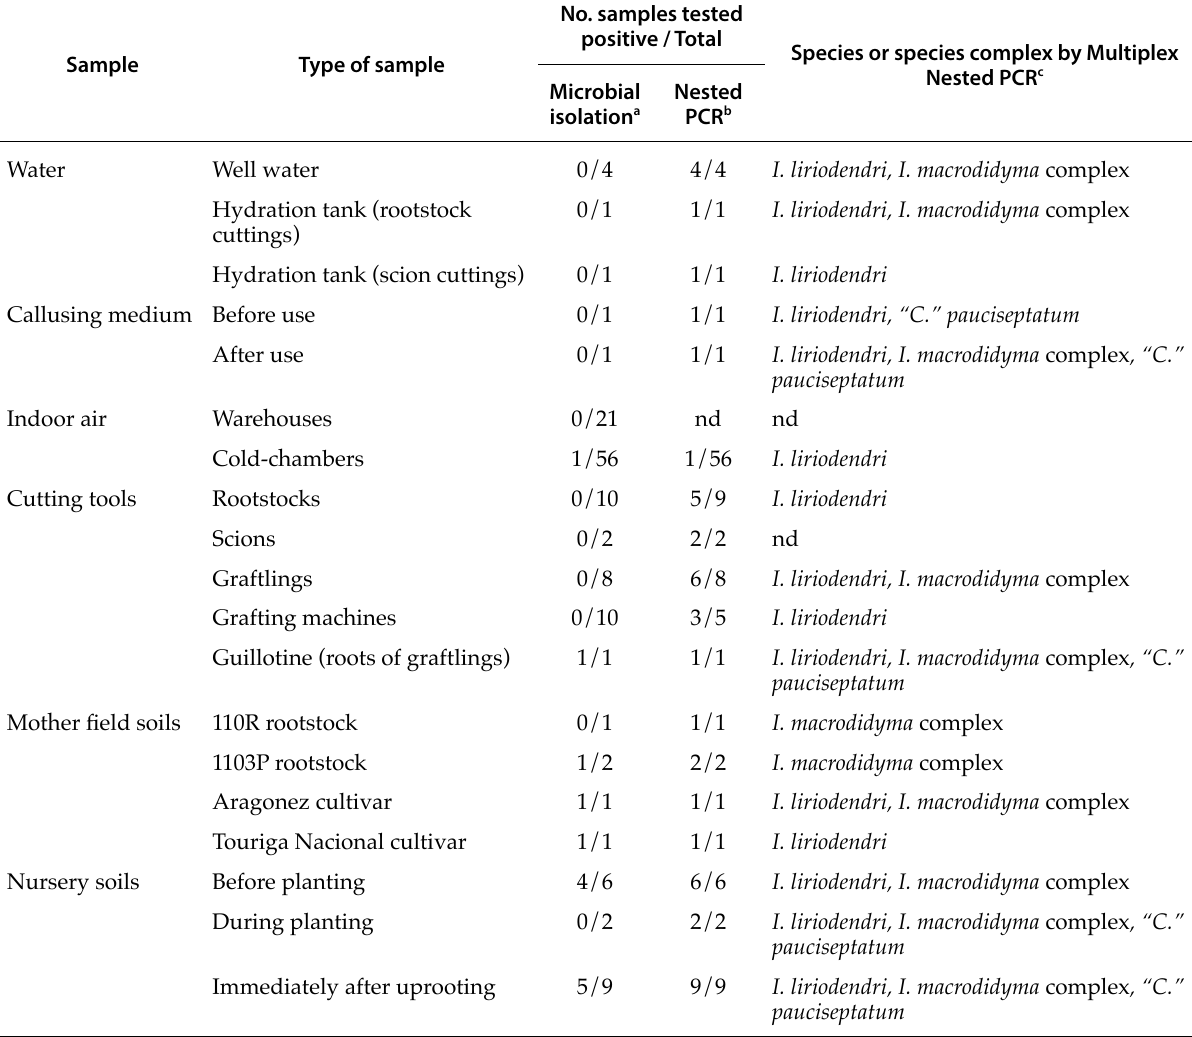
Table 2. Detection of Ilyonectria liriodendri , I. macrodidyma complex and “ Cylindrocarpon ” pauciseptatum in samples from water, callusing medium, indoor air, cutting tools and mother field and nursery